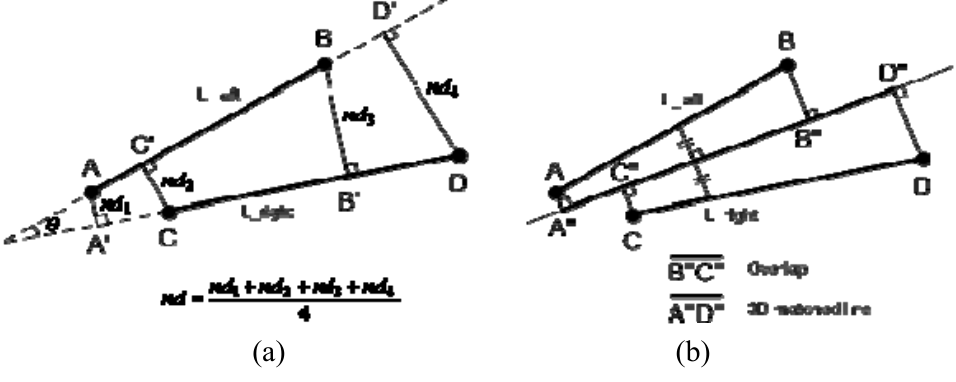
Figure 6. Matching straight line segments in warped images using (a) angle and normal distance constraints and (b) the presence of overlap and 3D matched